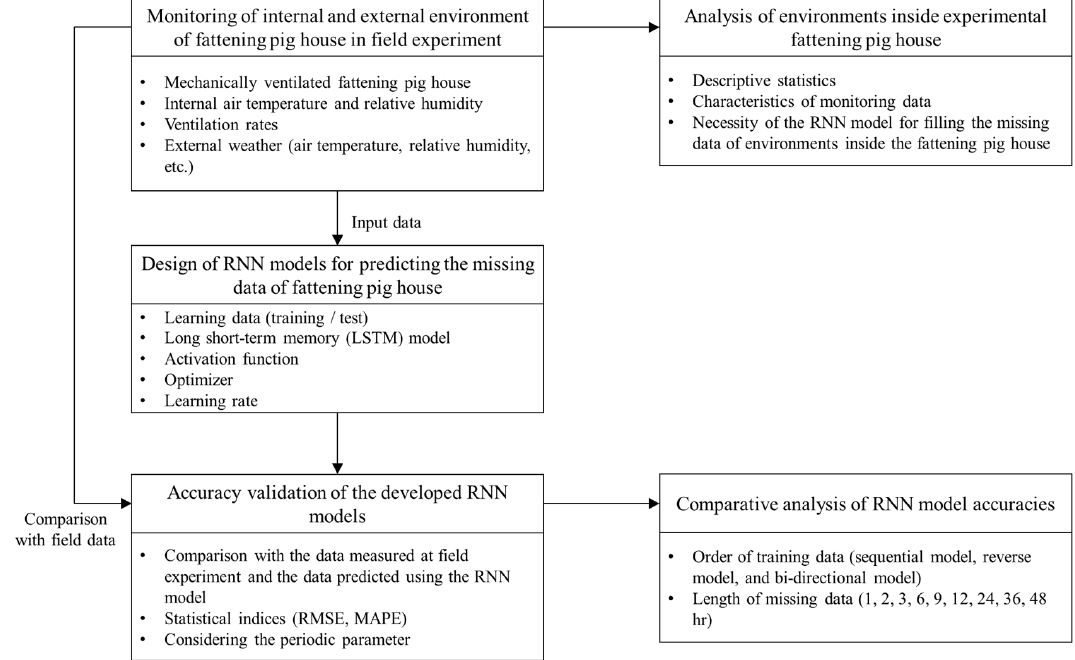
Figure 1. Flow chart of the experimental procedure of this study to develop the RNN model.